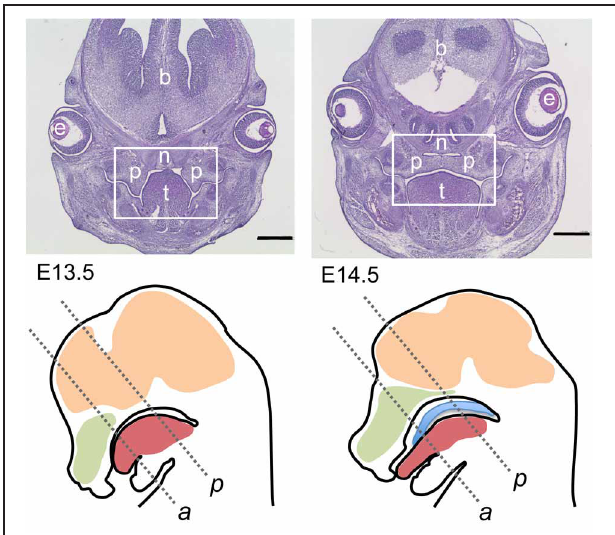
FIGURE 1 | Overview on mouse sections used for this study. Top row: Hematoxylin/eosin-stained frontal sections though the heads of E13.5 (top left) and E14.5 (top right) wildtype embryos; level of posterior palate. The boxed areas correspond to the palatal region depicted in the following figures. At E13.5 the palatal shelves are vertically oriented on each side of the tongue, whereas at E14.5 the shelves have elevated above the tongue and meet at the midline epithelial seam. p, Palatal shelves; t, tongue; n, nasal cartilage; e, eye; b, forebrain. Bar, 600 μ m. Bottom row: schematic drawings of midsagittal sections through the heads of E13.5 (left) and E14.5 (right) wildtype mouse embryos. The two frontal section planes used in this study are indicated by dashed lines: a , level of anterior palate; p , level of posterior palate. Green, nasal cavity; red, tongue; ocre, brain; blue, elevated palate (E14.5).